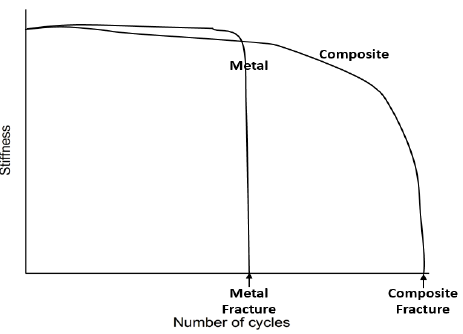
Figure 4. Schematic fatigue behavior comparison between a metal and a composite